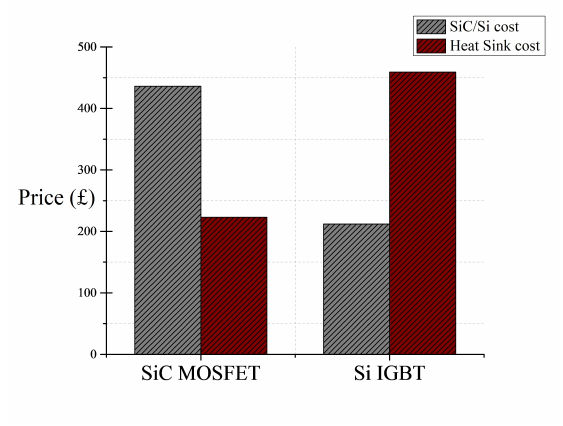
Figure 25. Cost comparison of Si and SiC